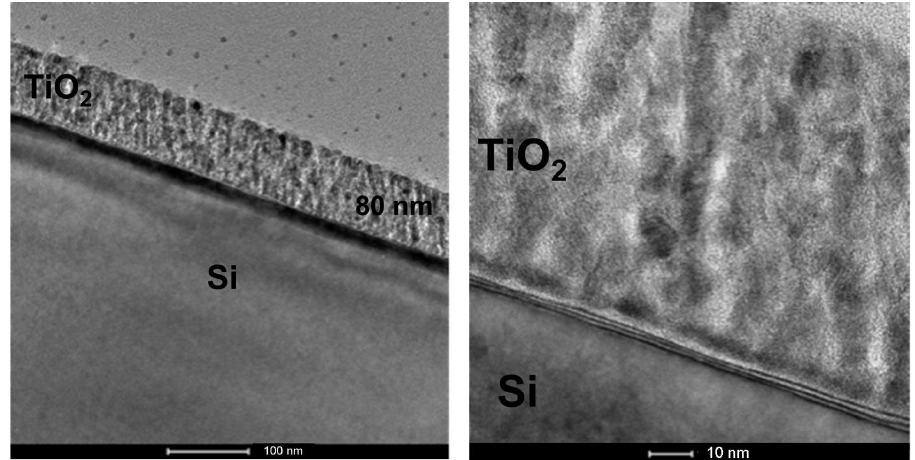
film, after deposition process at 860 °C. 2